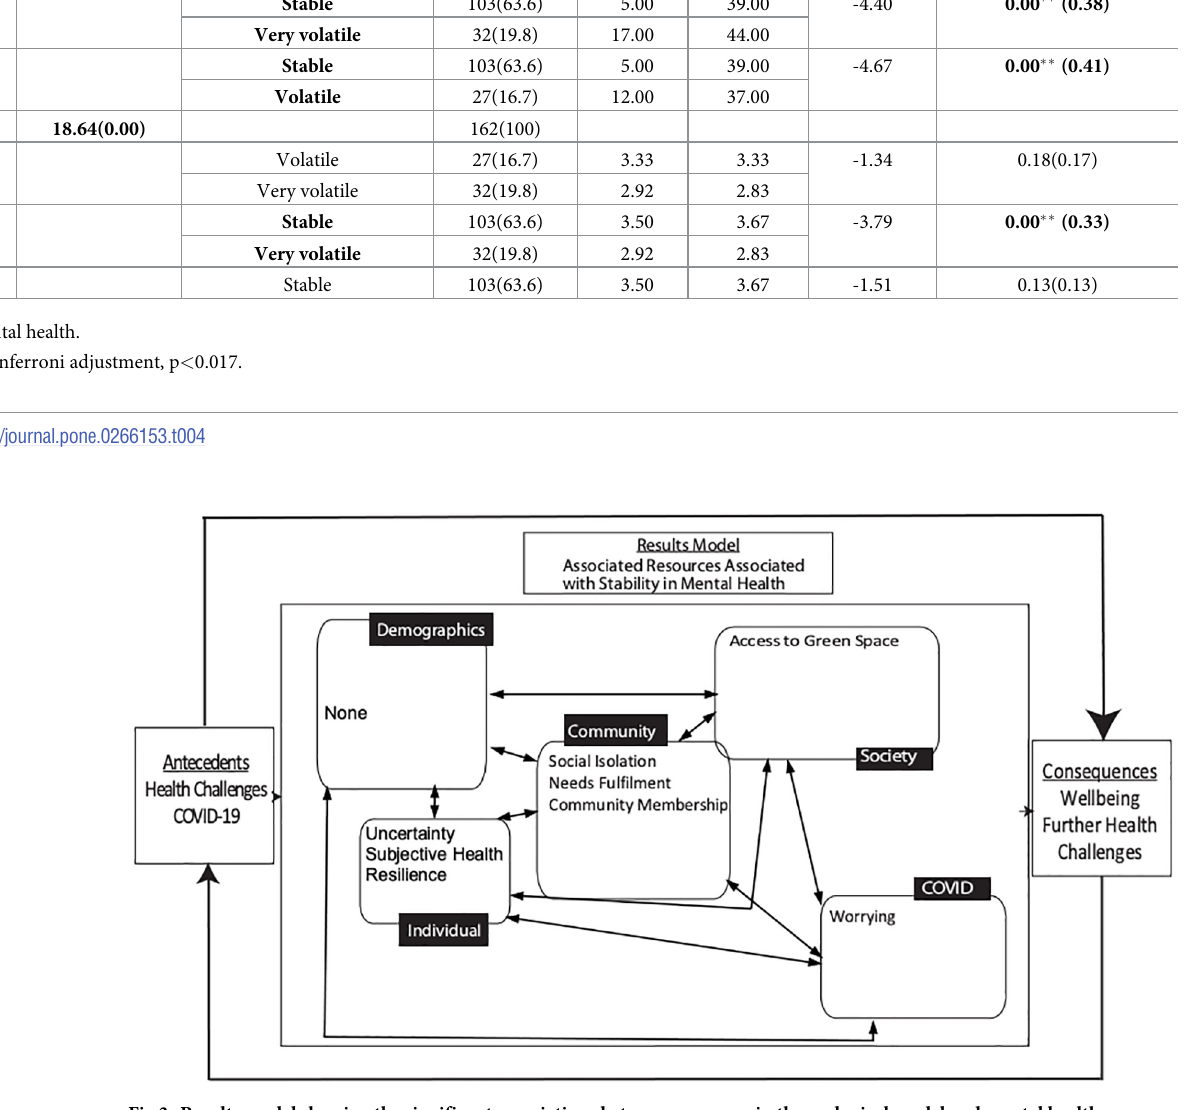
Fig 3. Results model showing the significant associations between resources in the ecological model and mental